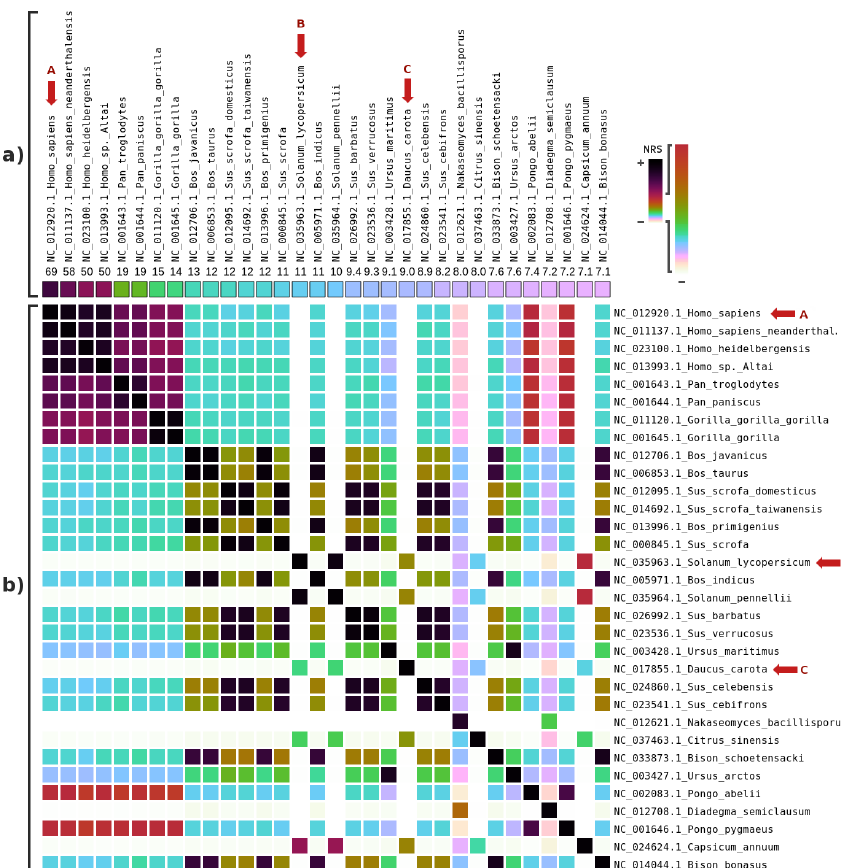
Figure 3. Metagenomic (mitochondrial) composition analysis of the reads, from the PUM sample, that did not exceed a similarity threshold relative to the Ursus maritimus reference sequence of 0.95: ( a ) the percentage of the highest NRS entries in descending order (from left to right), according to the order of the names at the top; and ( b ) the intra-similarities of the mitochondrial genomes based on the NRS. Letters (in red) identify potential genomes contained in the